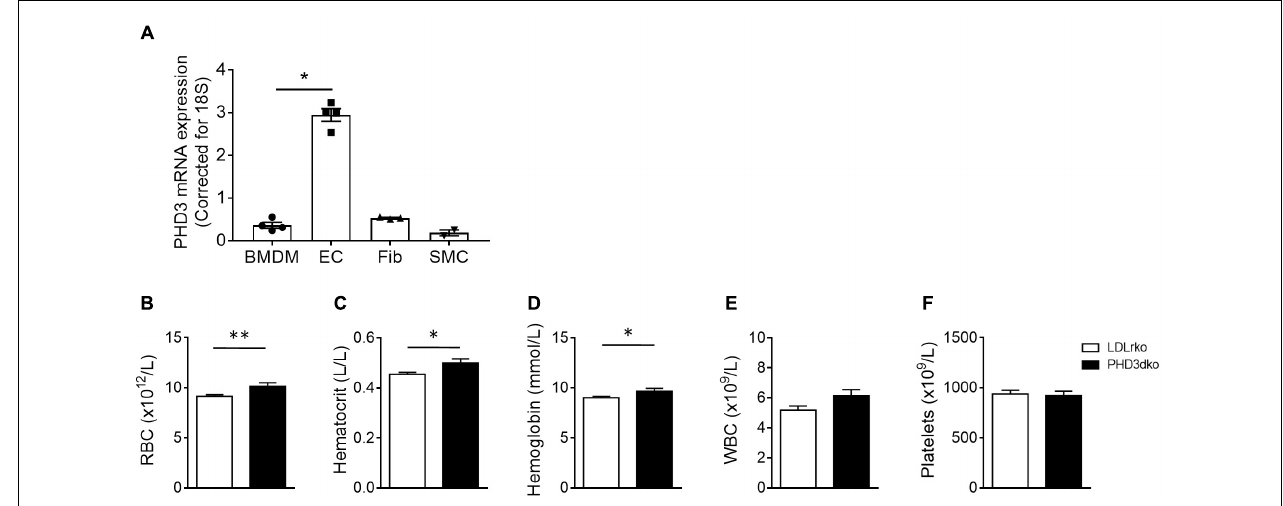
FIGURE 1 | All vascular cells expressed PHD3 and increased Hb and Ht confirmed functional PHD3ko. (A) PHD3 mRNA expression in vascular cells involved in atherosclerosis in vitro ( n = 4 replicates per group). Expression is depicted as relative expression, corrected for 18S. (B–F) Hematopoietic variables of LDLrko ( n = 21) and PHD3dko ( n = 14) mice measured from blood drawn upon sacrifice. (B) Red blood cells (RBC), (C) Hematocrit, (D) Hemoglobin, (E) White blood cells (WBC), and (F) Platelets. BMDM, bone marrow derived macrophage; SMC, smooth muscle cell; Fib, 3T3 fibroblast; EC, mouse cardiac endothelial cell. All results show mean ± SEM. ∗ p < 0.05, ∗∗ p <